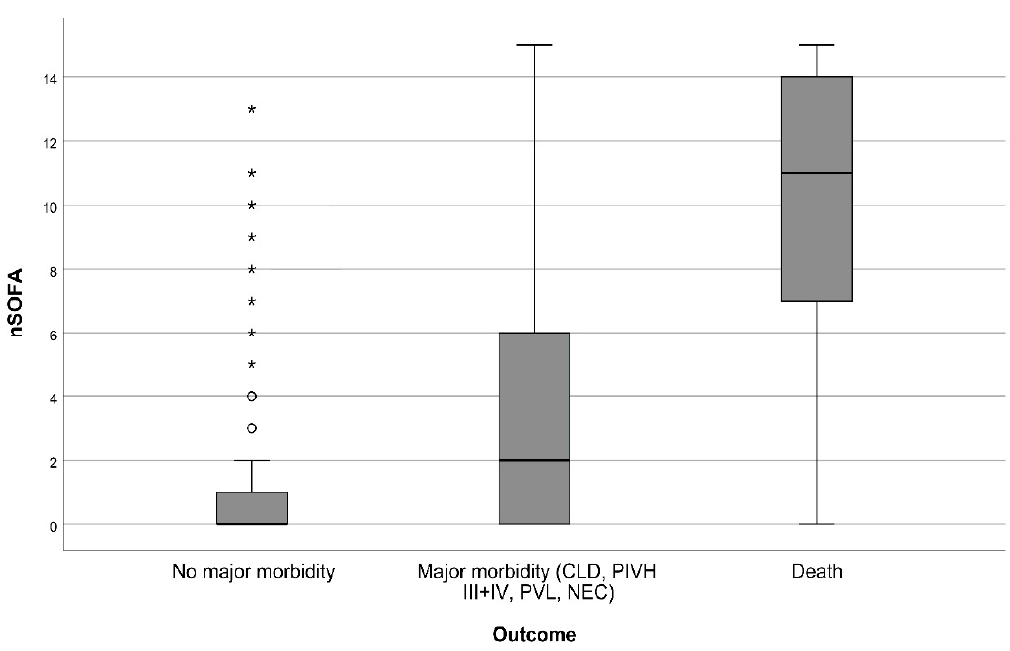
Figure 3. Comparison of nSOFA score peak values in the first 72 h after birth in subgroups without major morbidity (median 0, IQR 0–1), with major morbidity (median 2, IQR 0–6) and death (median 11, IQR 7–14). Independent samples Kruskal-Wallis test, p -value < 0.001. Circles represent outliers, stars represent far out values according to Tukey’s fences. nSOFA = Neonatal Sequential Organ Failure Assessment. CLD = Chronic Lung Disease. PIVH = Peri/Intraventricular Haemorrhage. PVL = Periventricular Leukomalacia. NEC = Necrotizing Enterocolitis.